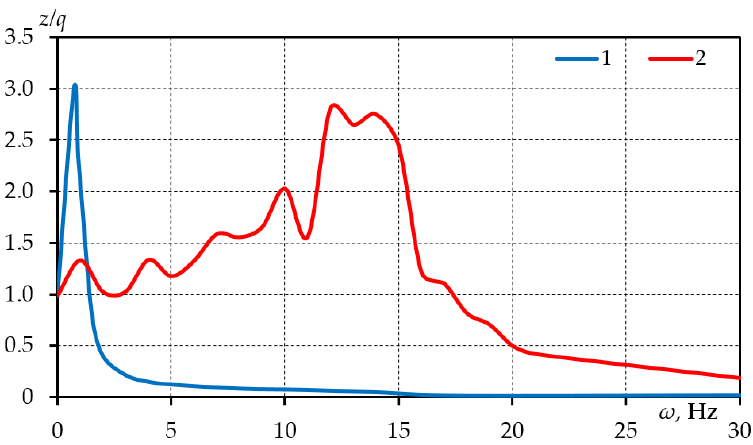
Figure 11. The frequency characteristic of the vehicle was determined with a numerical experiment: 1 — sprung mass; 2 — unsprung mass.